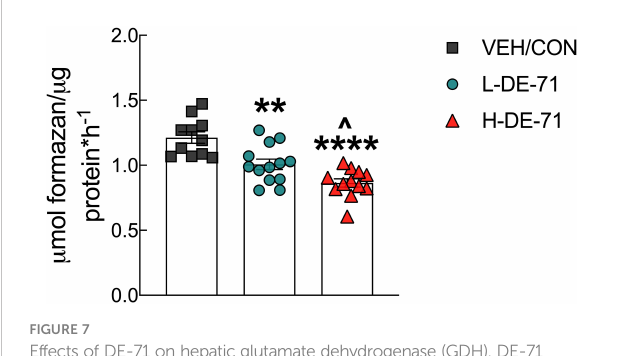
FIGURE 7 Effects of DE-71 on hepatic glutamate dehydrogenase (GDH). DE-71 exposure decreased GDH activity in a dose-dependent manner. *indicates signi fi cantly different from VEH/CON (** p < 0.01, **** p <0.0001); ^indicates signi fi cantly different from L-DE-71 (^ p < 0.05). Bars and error bars represent values expressed as mean ± s.e.m. n =11-13/group.